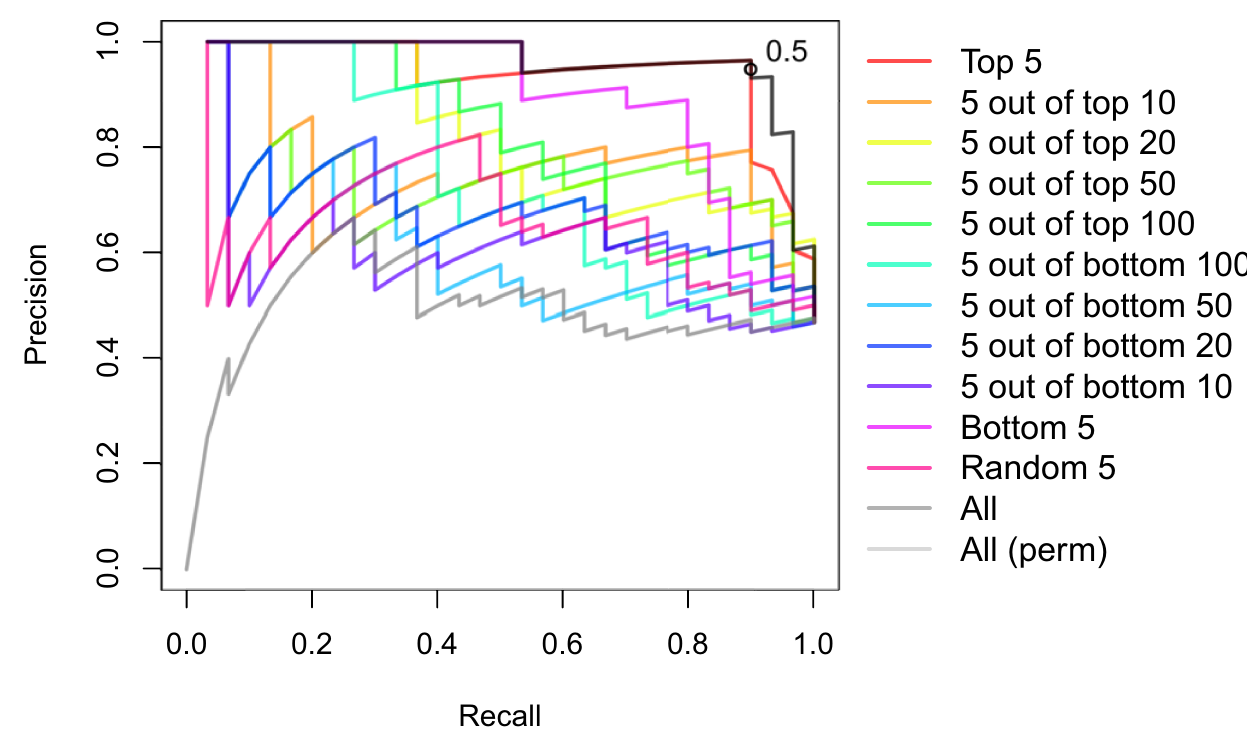
Fig 6. Precision-recall curves from predicting ‘good’ and ‘bad’ performers based on subsets of the ranked parental features. ‘Bad’ and ‘good’ performers were predicted using support vector machines (SVM), each trained with different subsets of parental features, based on the median relative importance for predicting the heterotic mode of action. The models were trained with the top five parental features (‘Top 5’); five randomly drawn from the top 10/20/50/100 features (‘5 out of top 10’/‘5 out of top 20’/‘5 out of top 50’/‘5 out of top 100’, respectively); five randomly drawn from the bottom 10/20/ 50/100 features (‘5 out of bottom 10’/‘5 out of bottom 20’/‘5 out of bottom 50’/‘5 out of bottom 100’, respectively); bottom five parental features (‘Bottom 5’); five randomly drawn from all features (‘Random 5’). In each model, the class probabilities attributed to the hybrids in the test set were then used to compute precision and recall over multiple probability cutoffs ranging from 0 to 1. The open circle locates the point in the curve of ‘Top 5’ in which the probability cutoff is 0.5.